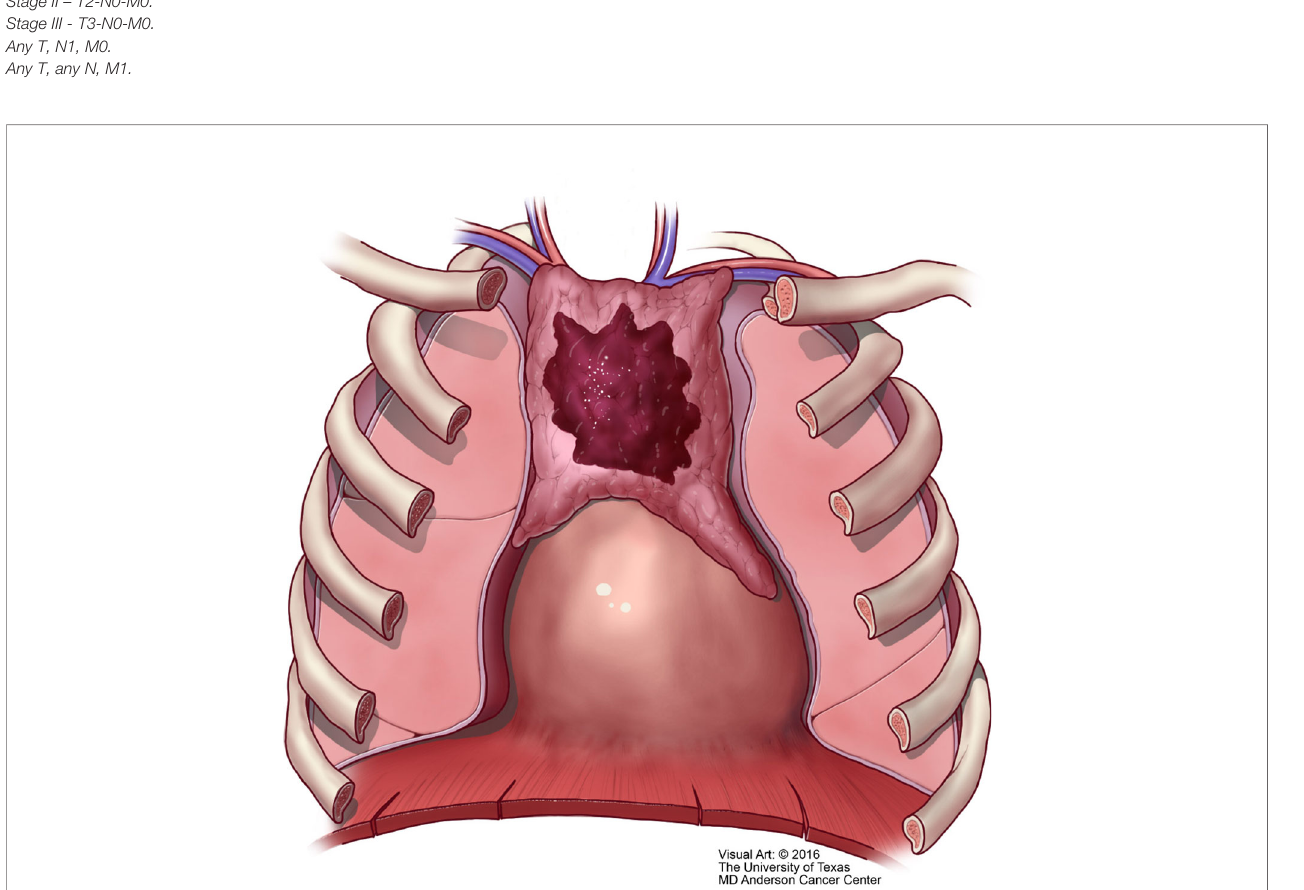
FIGURE 9 | T1 thymic carcinoma in which the tumor is limited to the mediastinal compartment.